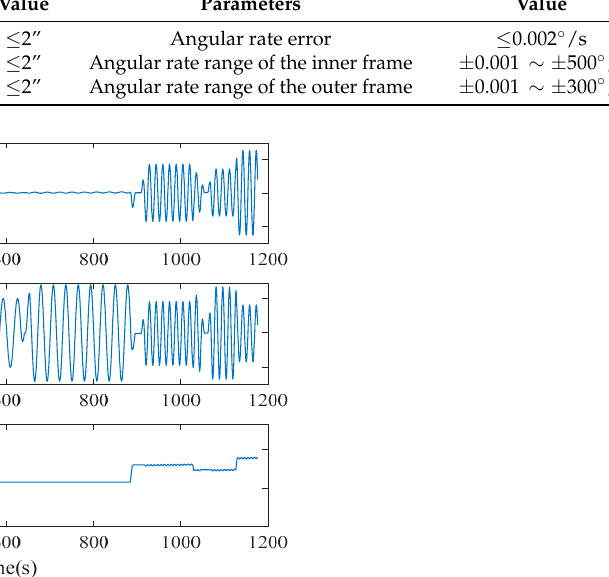
Figure 12. Experimental results of installation errors for URM 3#.